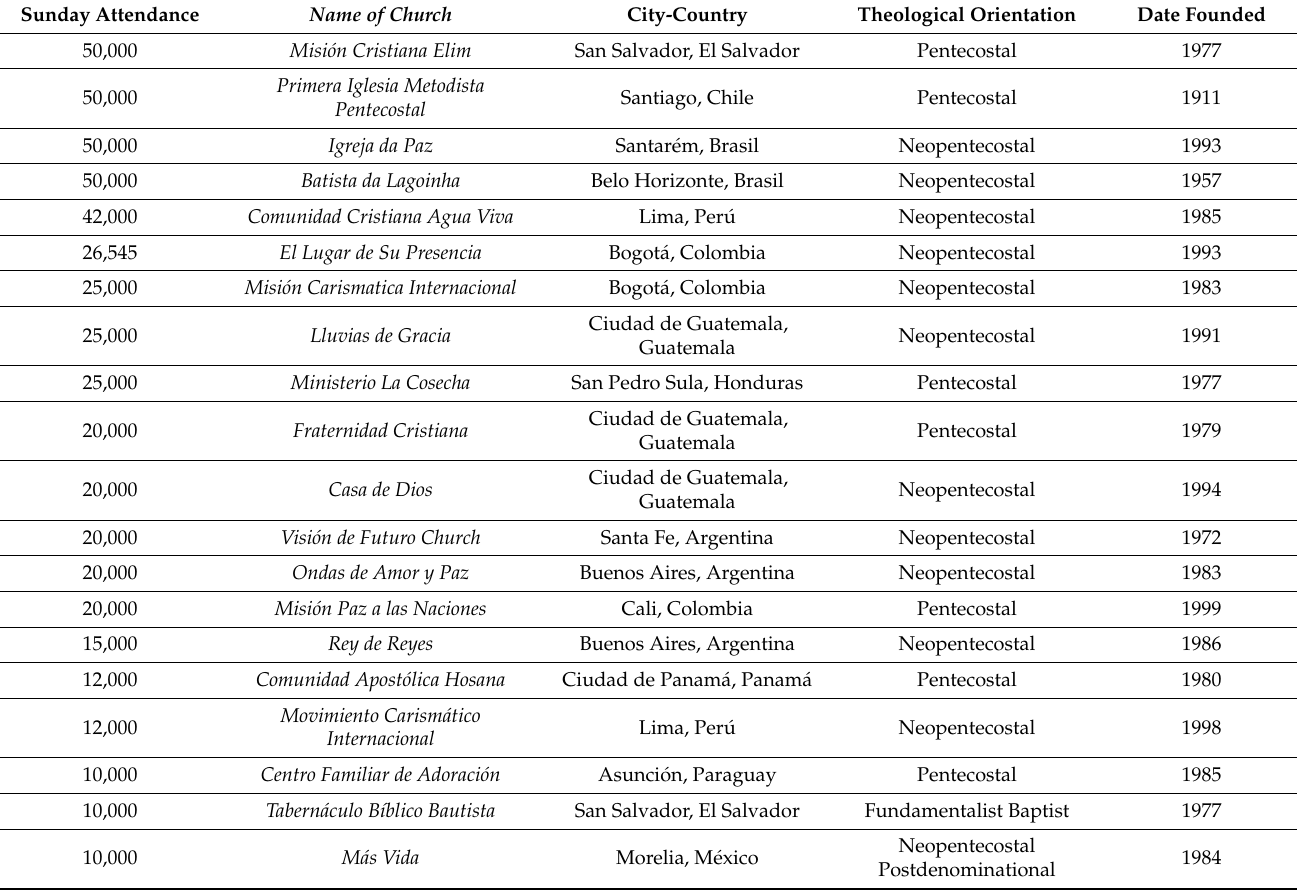
Table 1. Largest megachurches in Latin America (modified from Leadership Network